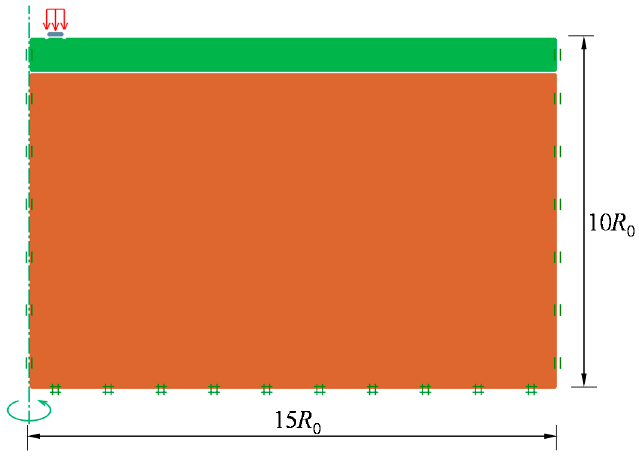
Figure 2. Numerical model of the problem in